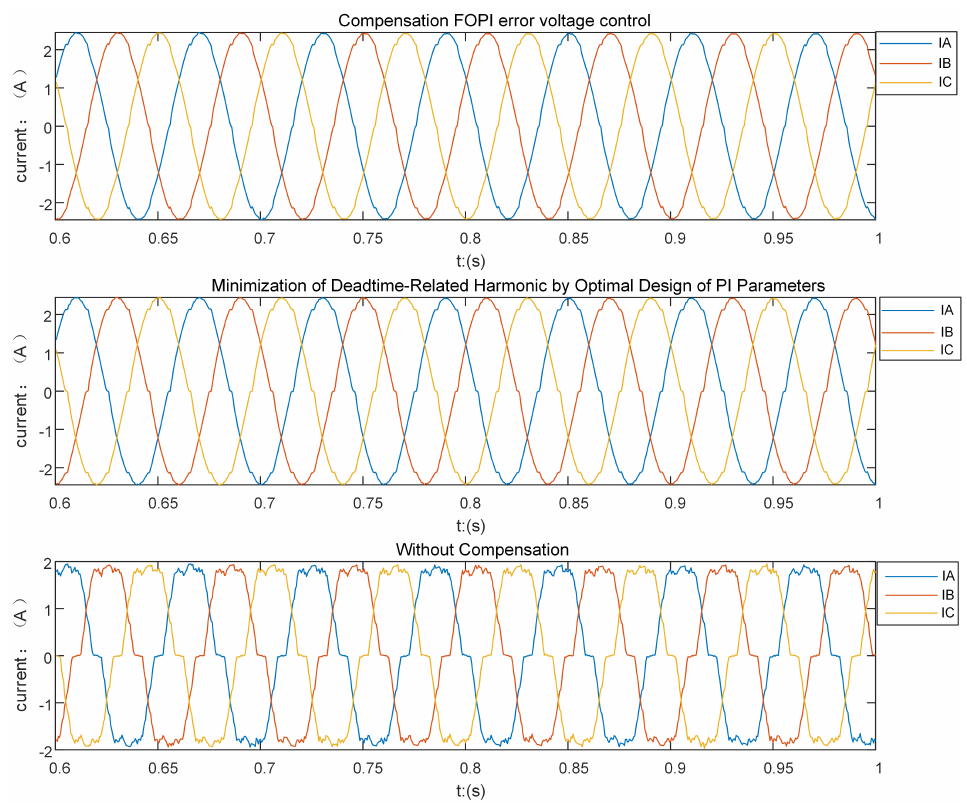
Figure 18. Comparison of three phase current response under 200 r/min speed